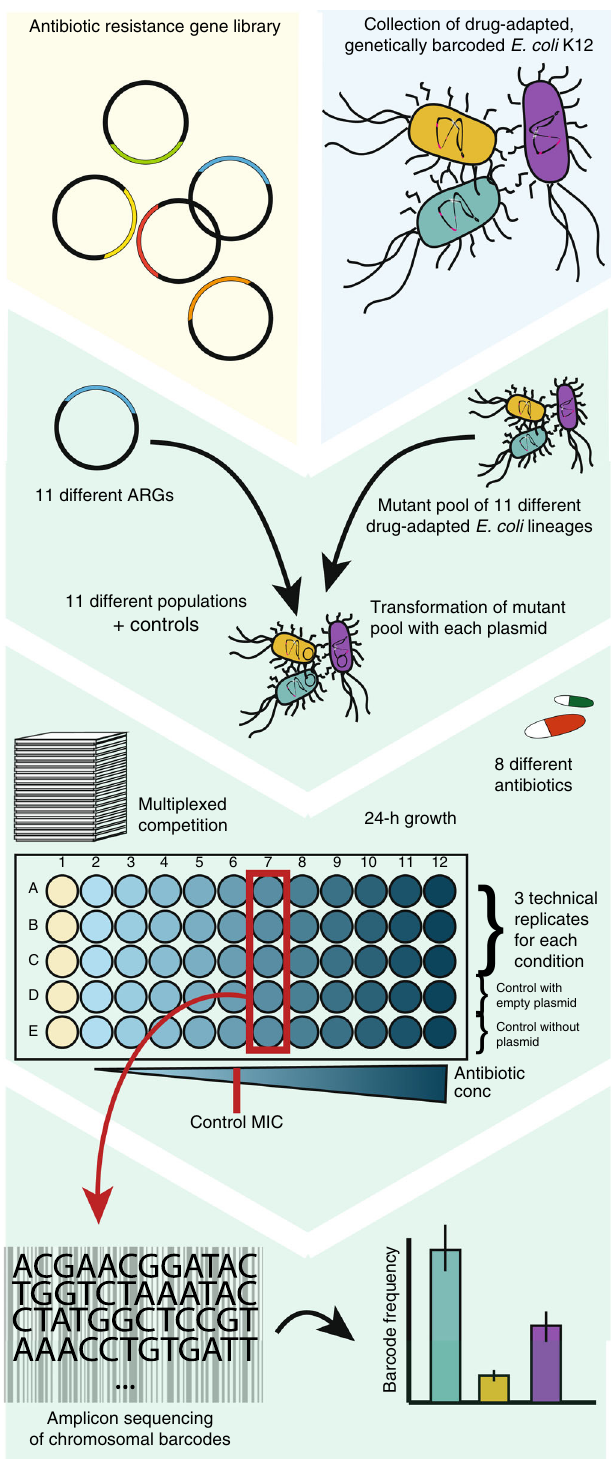
Fig. 1 Experimental overview. Eleven pools of 11 different mutants were individually transformed with 11 ARGs to create 121 unique ARG-mutant combinations. In addition, 23 combinations containing either the empty vector or the background E. coli MG1655 WT strain were made. The mutant pools containing each ARG were subjected to eight different drugs, as well as an antibiotic-free condition. At least two replicates of the individual pools were then sequenced to determine the abundance of each mutant